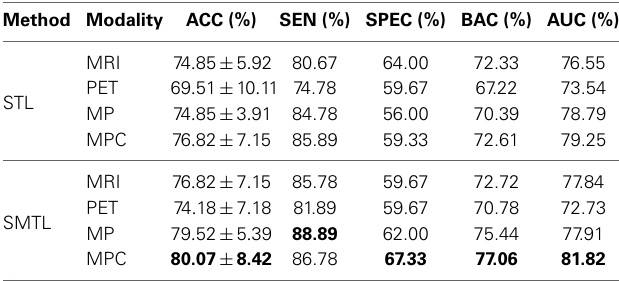
Table 4 | A summary of the performances for MCI vs. NC classification.